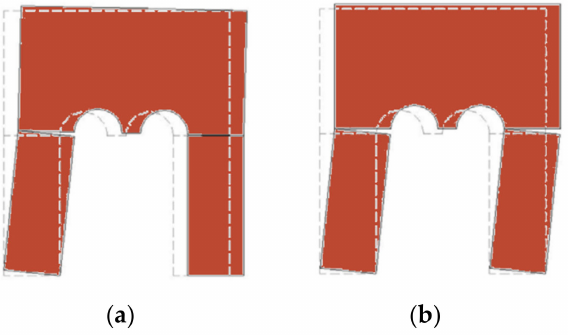
Figure 8. Variation of the acceleration needed to cause out-of-plane